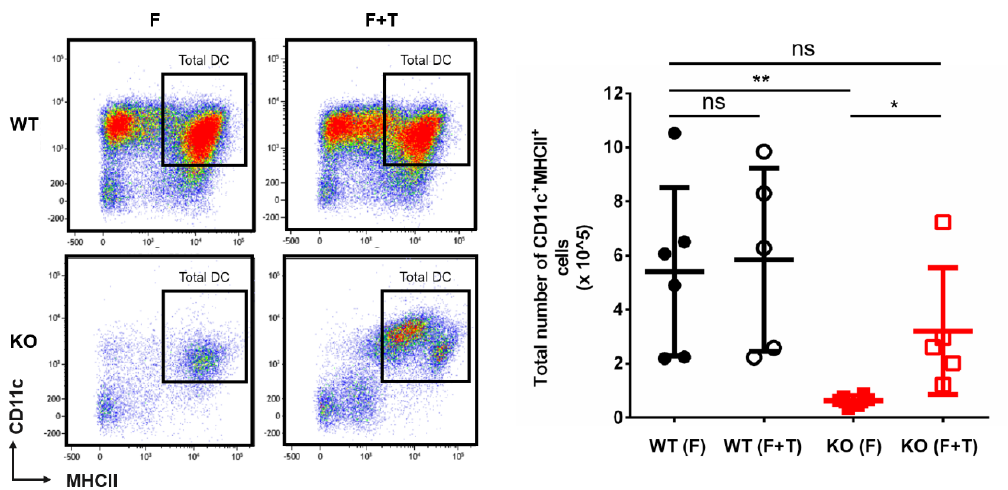
Figure 5. Addition of TNF rescues formation of mature DCs in the absence of Cebpa . In vitro formation of CD11c + MHCII + DCs is increased, when KO HSPCs are cultured with a combination of FLT3L (F) and TNFα (T) , as compared to FLT3L only. Data represent mean + SD ( n = 5–6 mice, * p < 0.01, ** p < 0.001; NS denotes nonsignificant) .